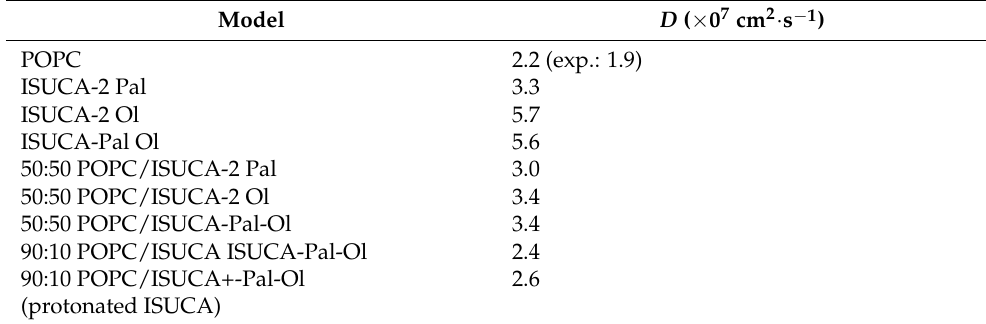
Table 2. Calculated D of the different bilayers